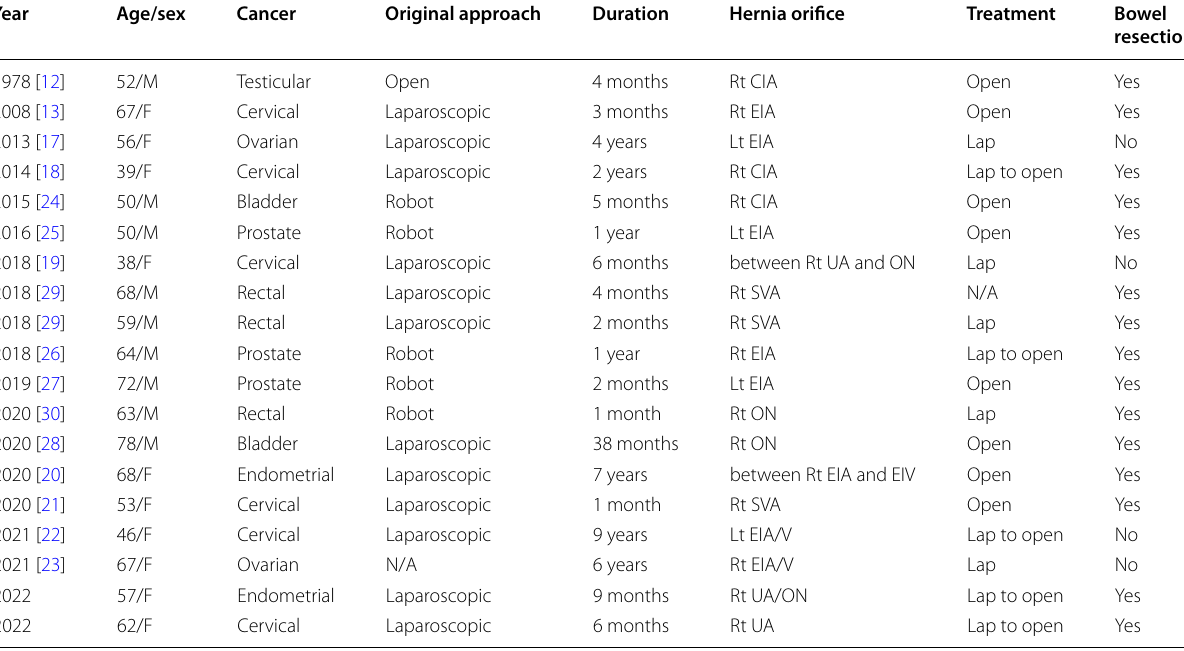
Duration stands for the time from the original surgery to the internal hernia surgery Lap, laparoscopic surgery; Open, open surgery; Robot, robot-assisted surgery; Rt, right; Lt, left; CIA, common iliac artery; EIA/V, external iliac artery/vein; UA, umbilical artery; ON, obturator nerve; SVA, superior vesical artery; N/A, not